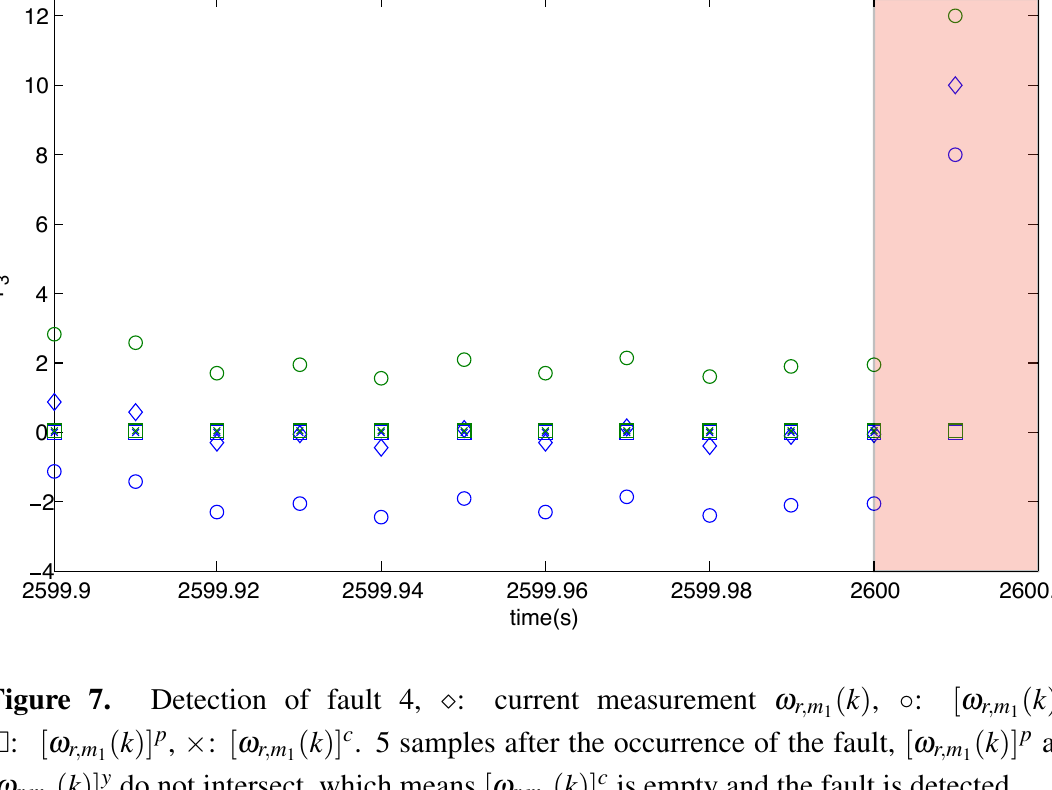
( k )] c is empty and the fault is r , m 1